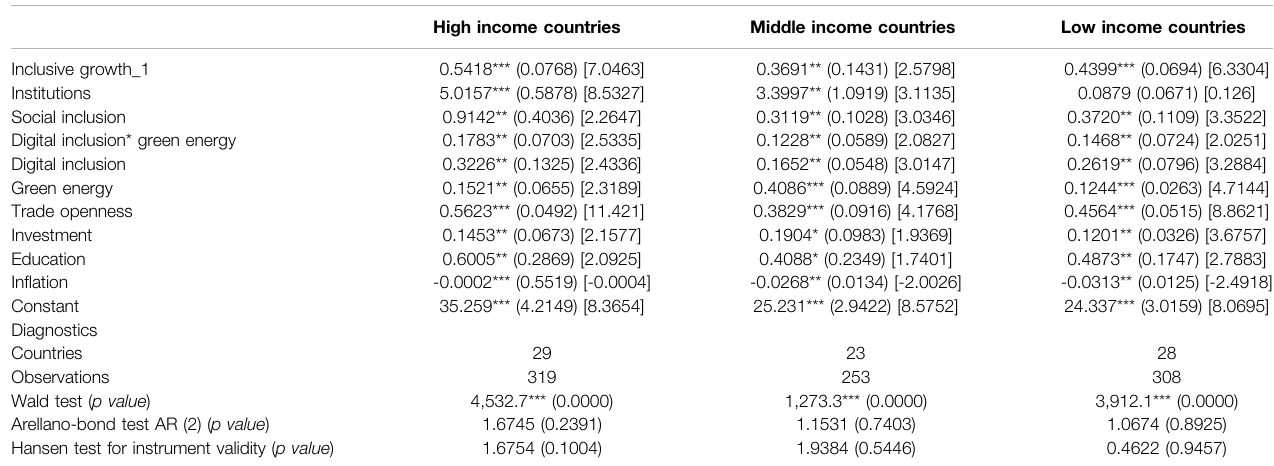
TABLE 3 | Results of digital inclusion and green energy